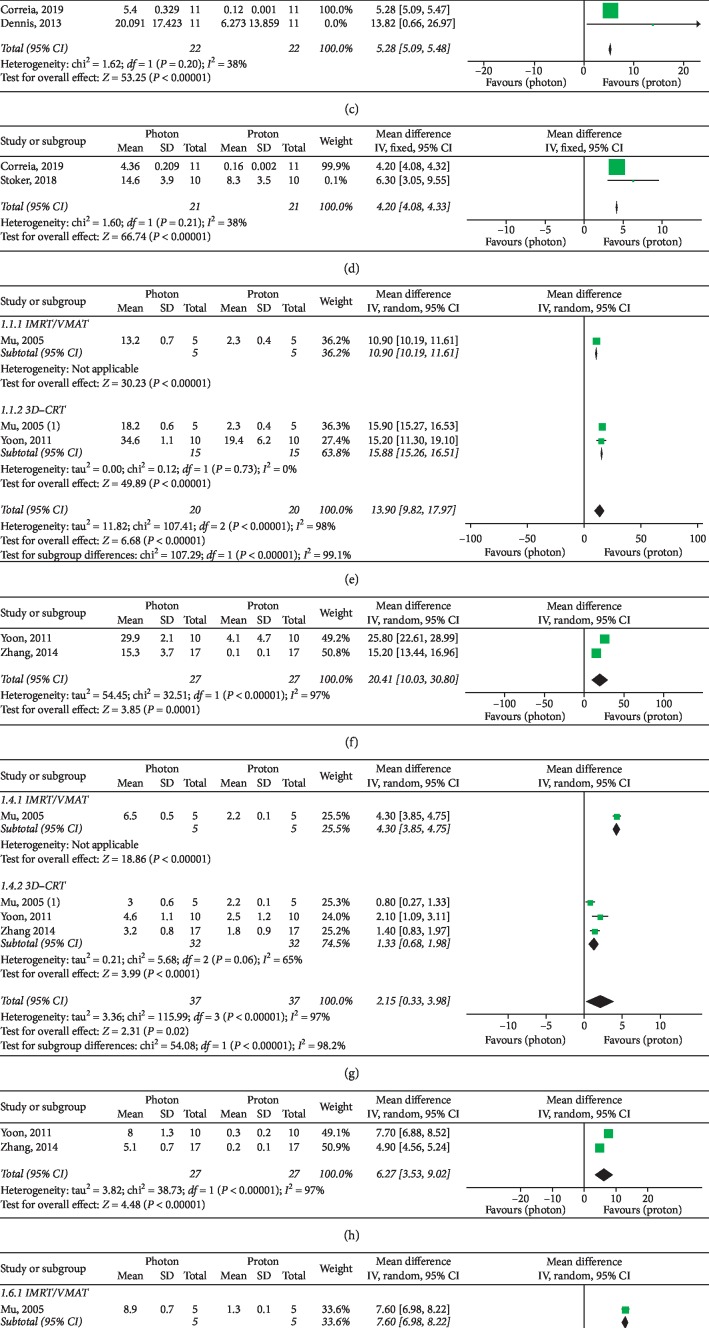
Dmean and Dmax of extracranial OARs. (a) Dmean - left lens. (b) Dmean - left lacrimal gland. (c) Dmean - right lacrimal gland. (d) Dmax - left lens. (e) Dmean - esophagus. (f) Dmean - thyroid. (g) Dmean - lungs. (h) Dmean - liver. (i) Dmean - kidneys. Mu, 2005: IMRT; Mu, 2005 (1): 3D-CRT.